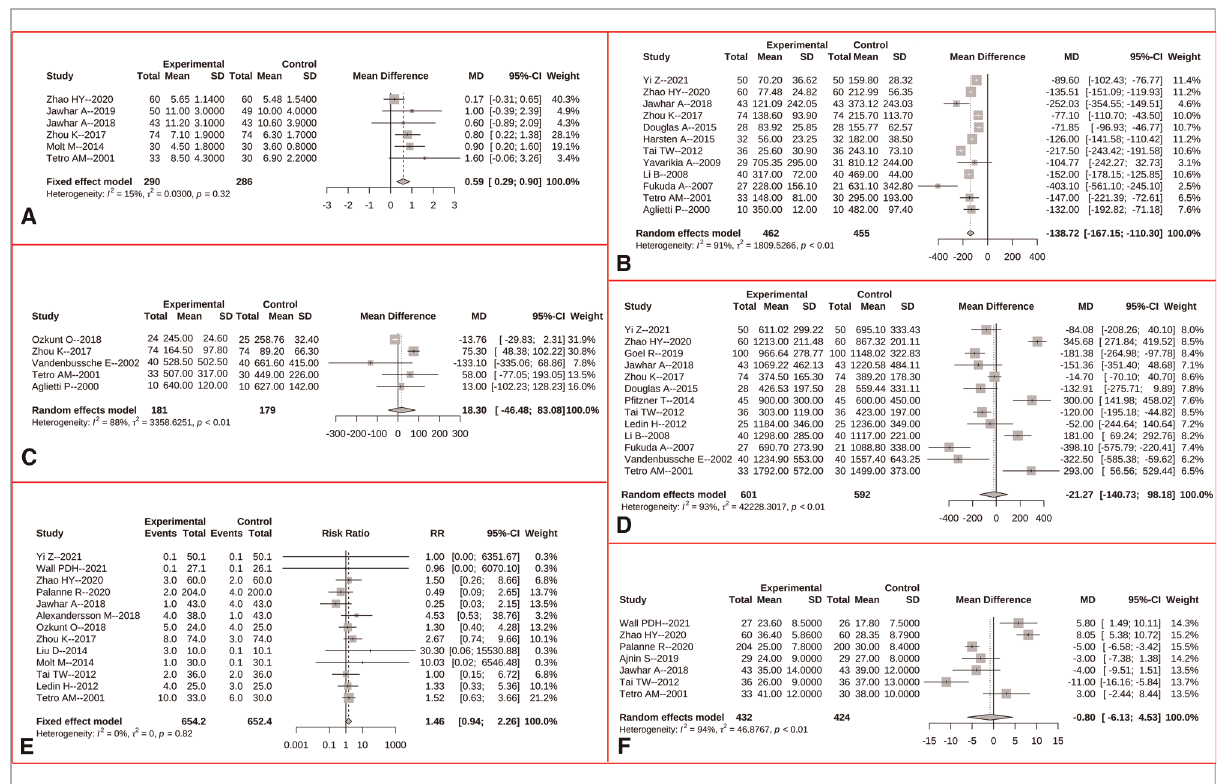
FIGURE 4 Forest plots for comparisons of length of hospital stay ( A ), intraoperative blood loss ( B ), draining volume ( C ), total blood loss ( D ), transfusion rate ( E ), and hemoglobin change ( F ) between the tourniquet (experimental) and non-tourniquet (control) groups. The I 2 were 15%, 91%, 88%, 93%, 0%, and 94% for the fi xed-effects, random-effects, random-effects, random-effects, fi xed-effects, and random-effect models, respectively.